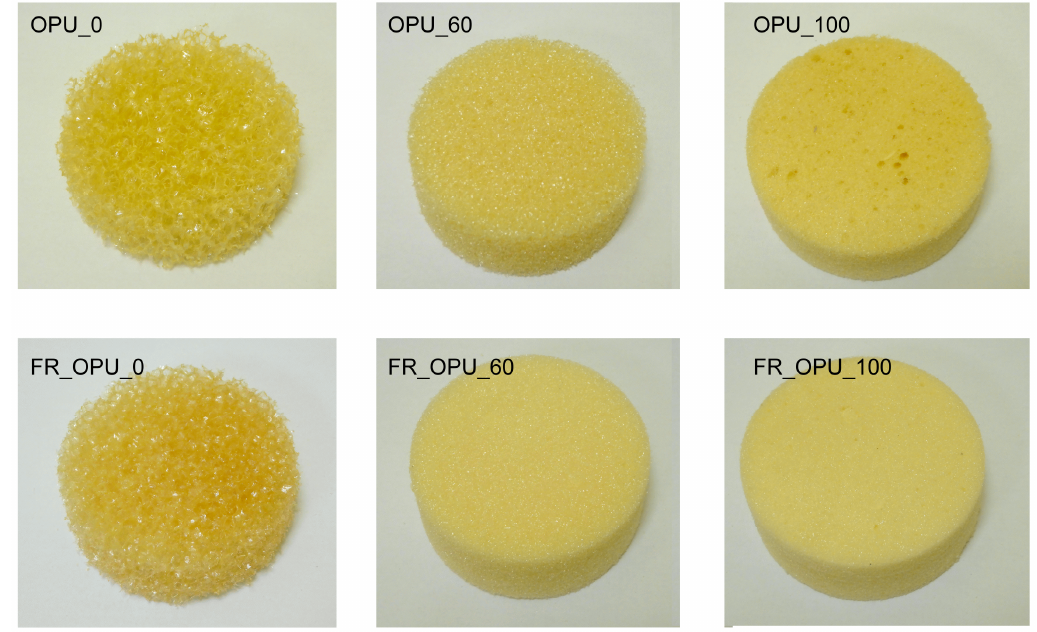
Figure 1. Photographs of 100 mm-diameter polyurethane (PUR) samples used for acoustic properties evaluation in the frequency range of 100–1000 Hz.